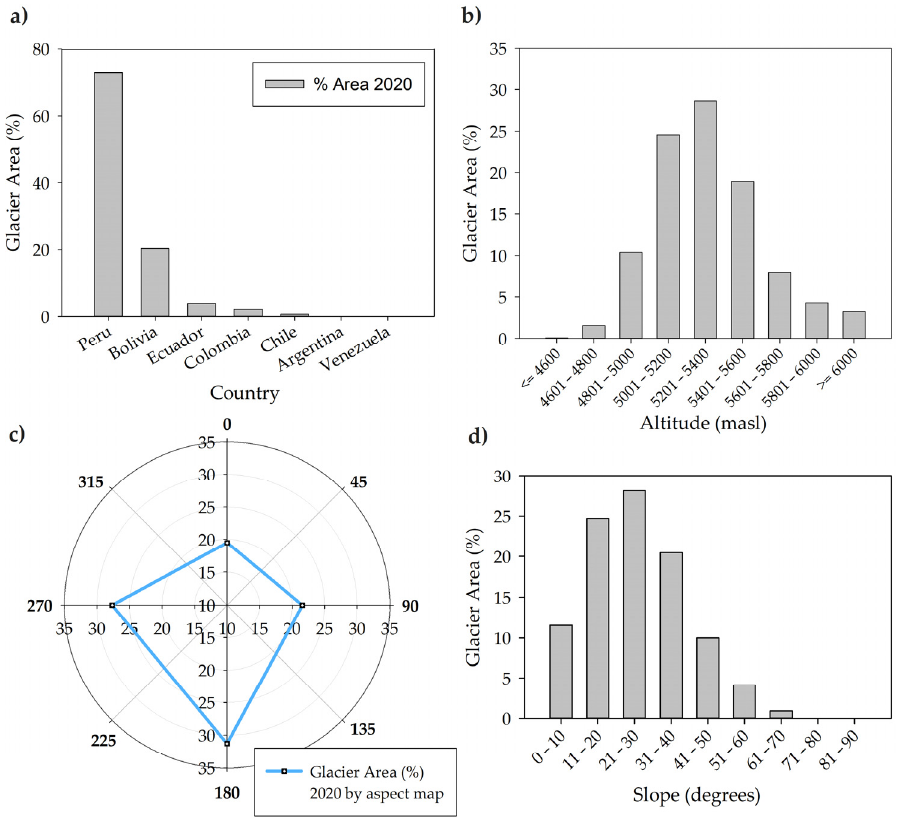
Figure 10. TAGs results for the year 2020: ( a ) percentage of the spatial distribution of glaciers by country; ( b ) occurrence of glaciers by altitude ranges; ( c ) distribution of glaciers by terrain aspect; and ( d ) percentage of spatial distribution of glaciers by terrain slope.